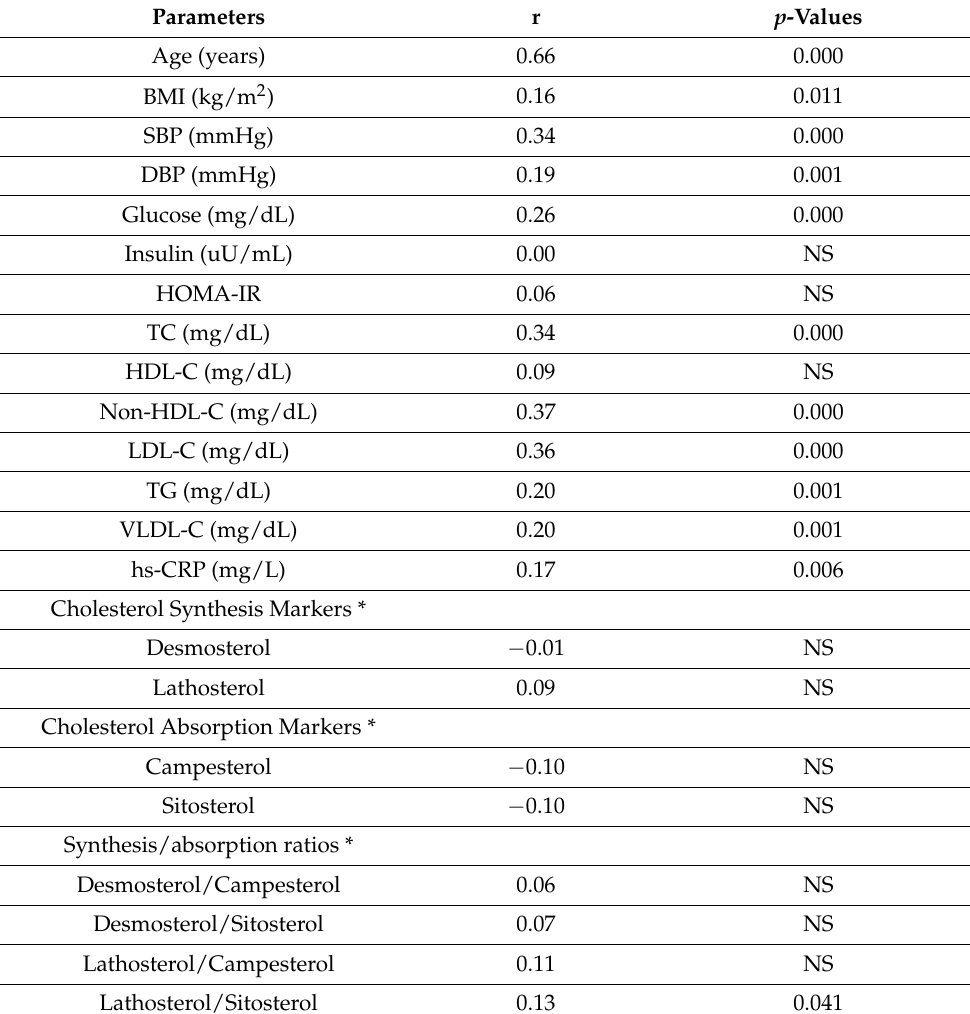
Table 2. Spearman’s correlation coefficients of cIMT with classical CVD risk parameters and with cholesterol synthesis and absorption